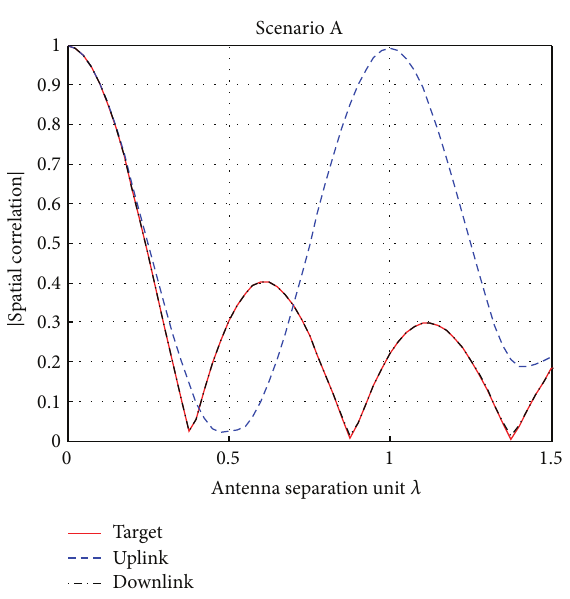
Figure 8: Spatial correlation of the downlink (with 𝑁 𝑑 = 16 ) and uplink (with 𝑁 𝑢 = 4 ) channel model for scenario